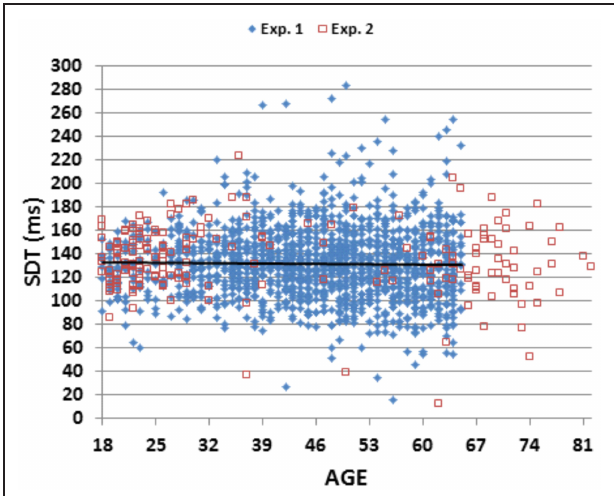
FIGURE 4 | Stimulus detection time (SDT) as a function of age. SDT was derived by subtracting the movement initiation time in a speeded finger tapping test from SRTs. The linear trend line is from Experiment 1